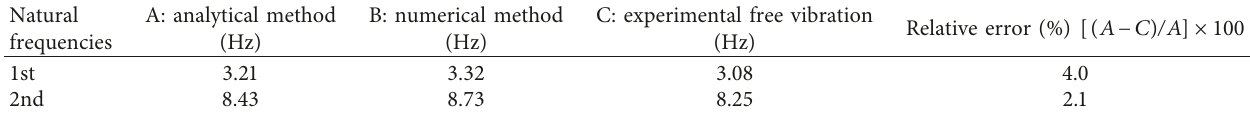
Table 4: Natural frequencies of the structure without absorbers (free vibration).